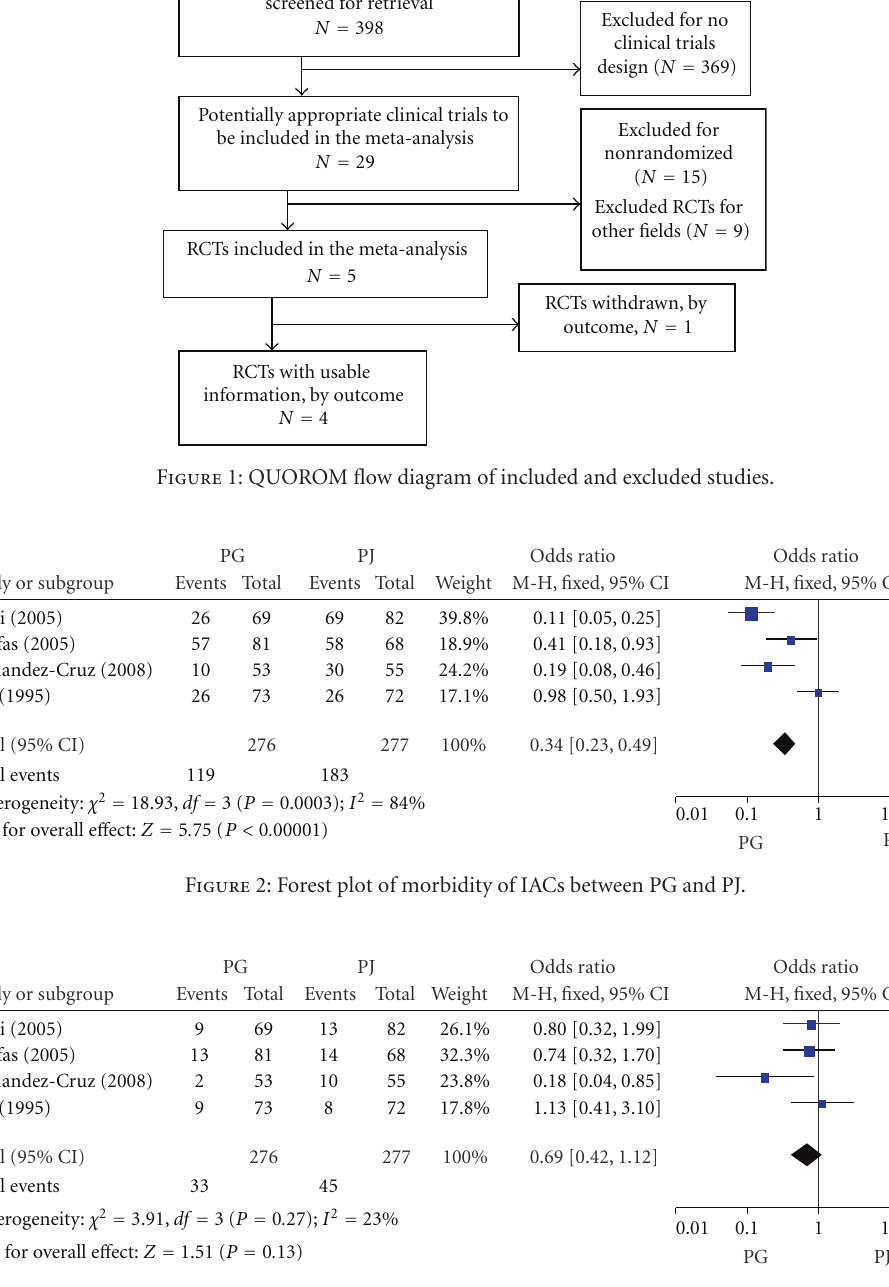
Figure 3: Forest plot of pancreatic fistula between PG and